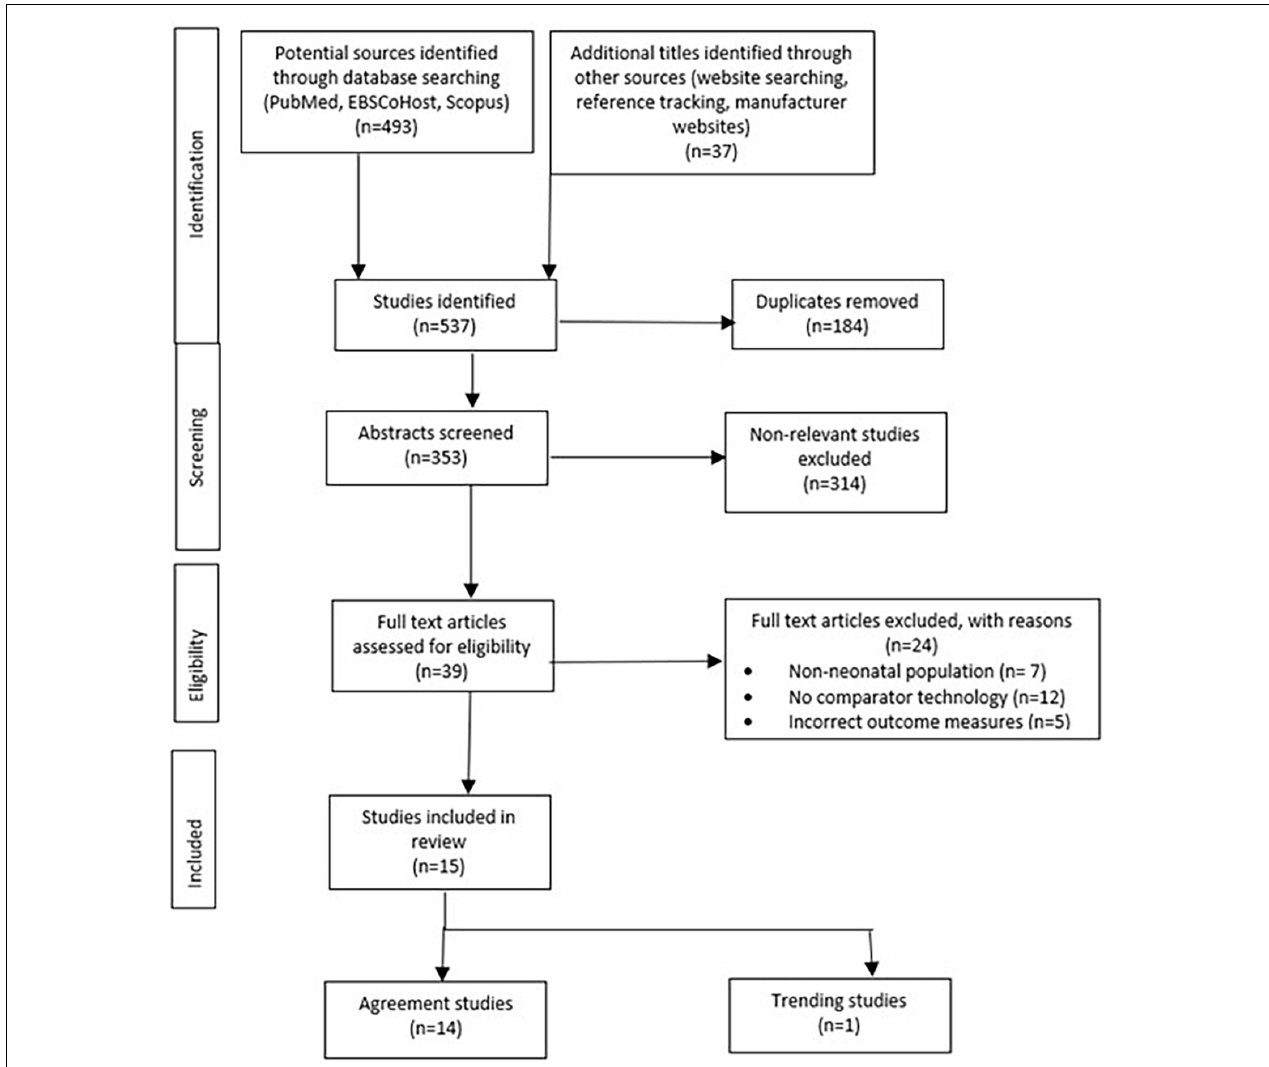
FIGURE 1 | Flow chart of literature search